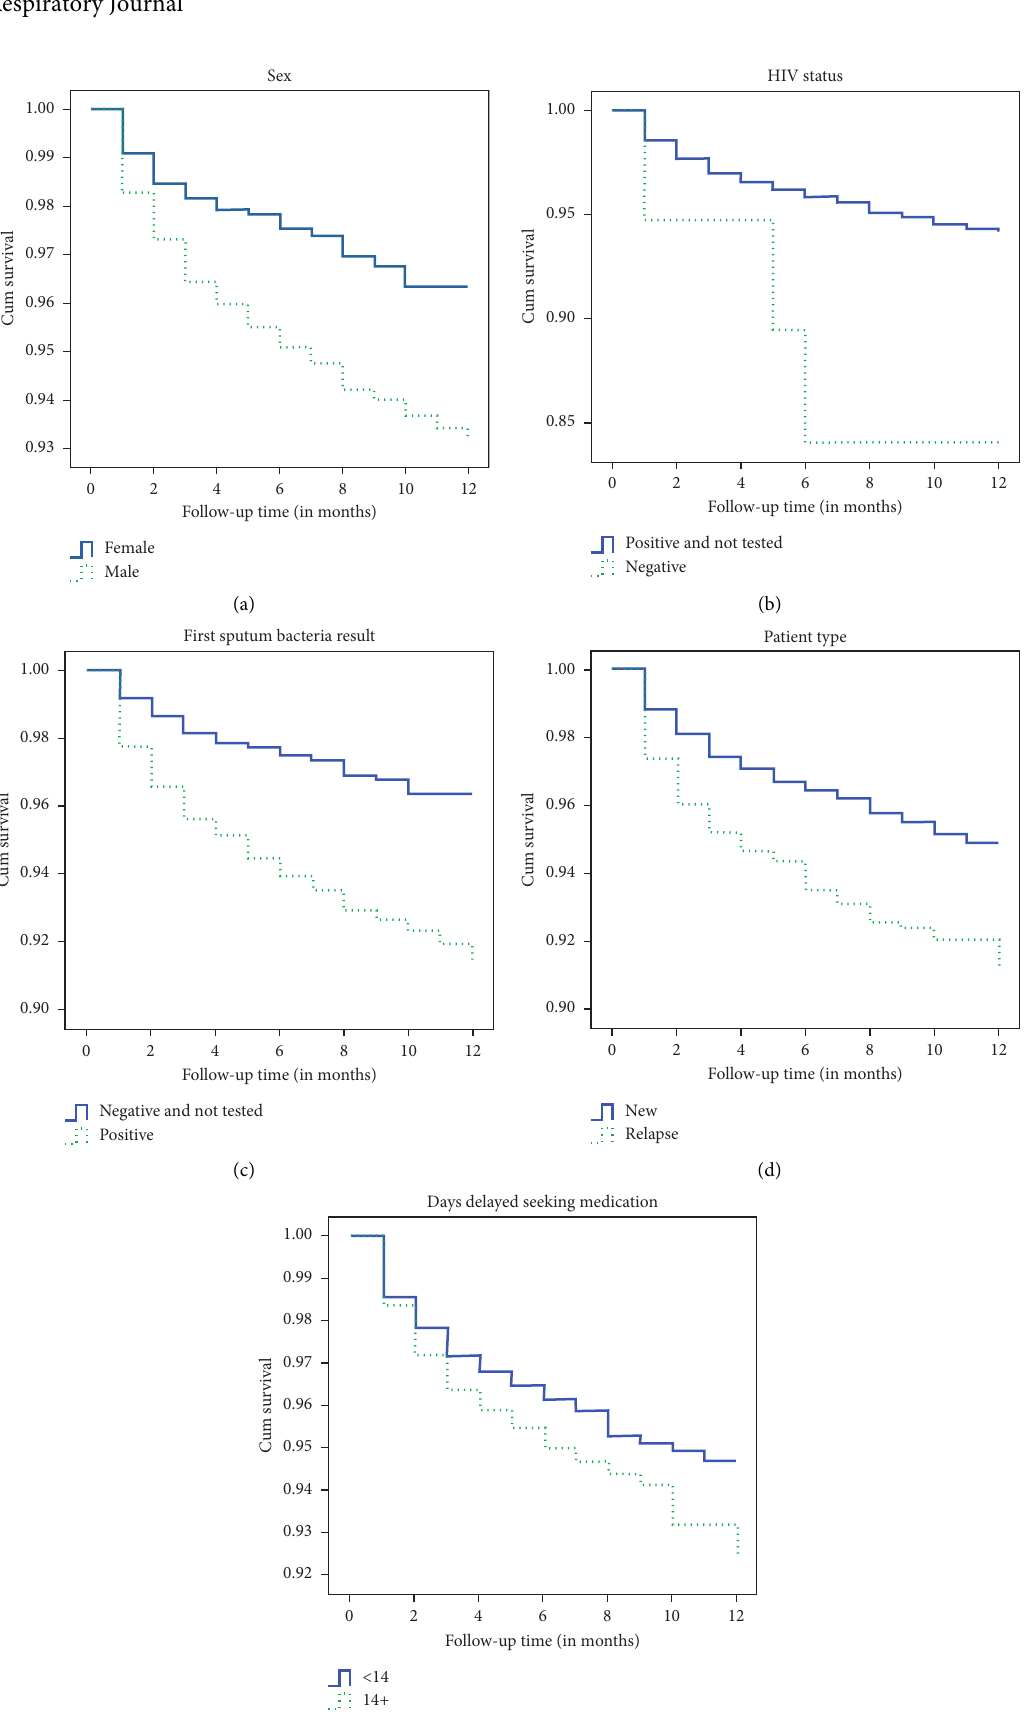
Figure 1: The plot of the estimate of Kaplan–Meier survivor curves of TB patients under DOTS. (a) Sex, (b) HIV status, (c) first sputum bacteria result, (d) TB patient type, and (e) days delayed seeking